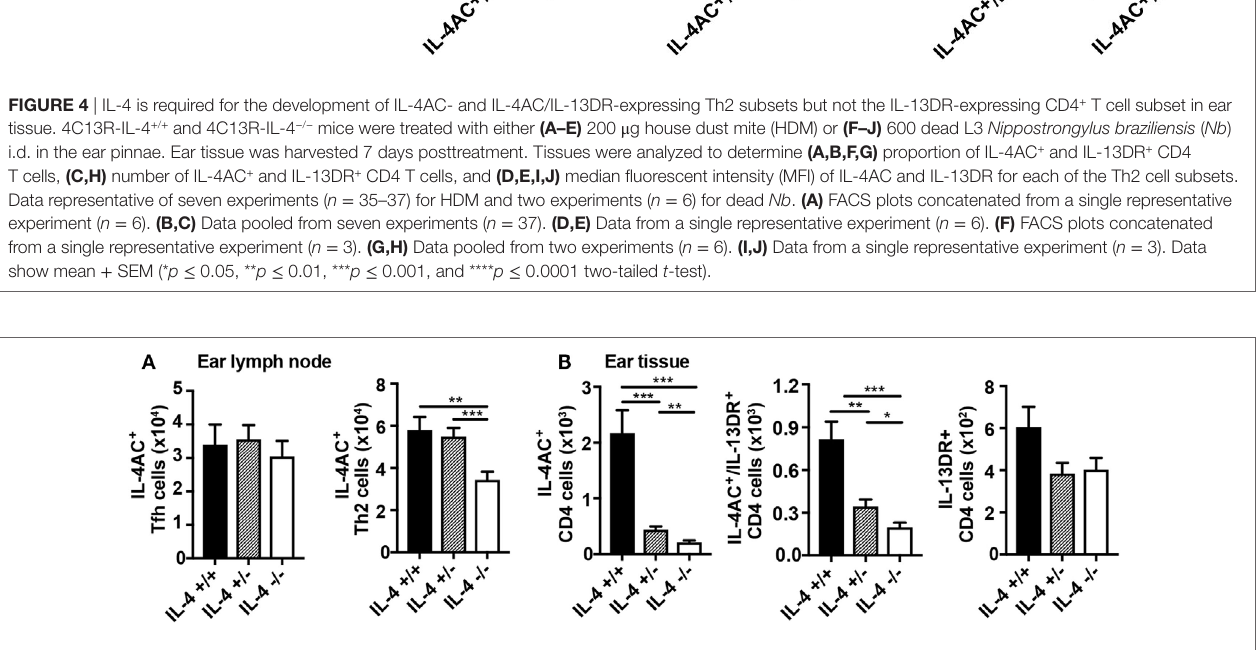
FigUre 5 | Reduction in IL-4 availability by Il4 gene hemizygosity has a partial effect on the development of IL-4AC- and IL-4AC/IL-13DR-producing T cell subsets. 4C13R-IL-4 + / + , 4C13R-IL-4 + / − , and 4C13R-IL-4 − / − mice were treated with 200 μ g house dust mite i.d. in the ear pinnae. Ear draining lymph nodes and ear tissue were harvested from the mice 7 days posttreatment. (a) Lymph nodes were analyzed to determine the number of IL-4AC + T follicular helper (Tfh) and IL-4AC + Th2 CD4 T cells. (B) Ear tissue was analyzed to determine the number of reporter + Th2 CD4 + T cells. (a) Data pooled from three experiments ( n = 18) for ear lymph node and (B) three experiments ( n = 15) for ear tissue. Data show mean + SEM (* p ≤ 0.05, ** p ≤ 0.01, and *** p ≤ 0.001 two-tailed t